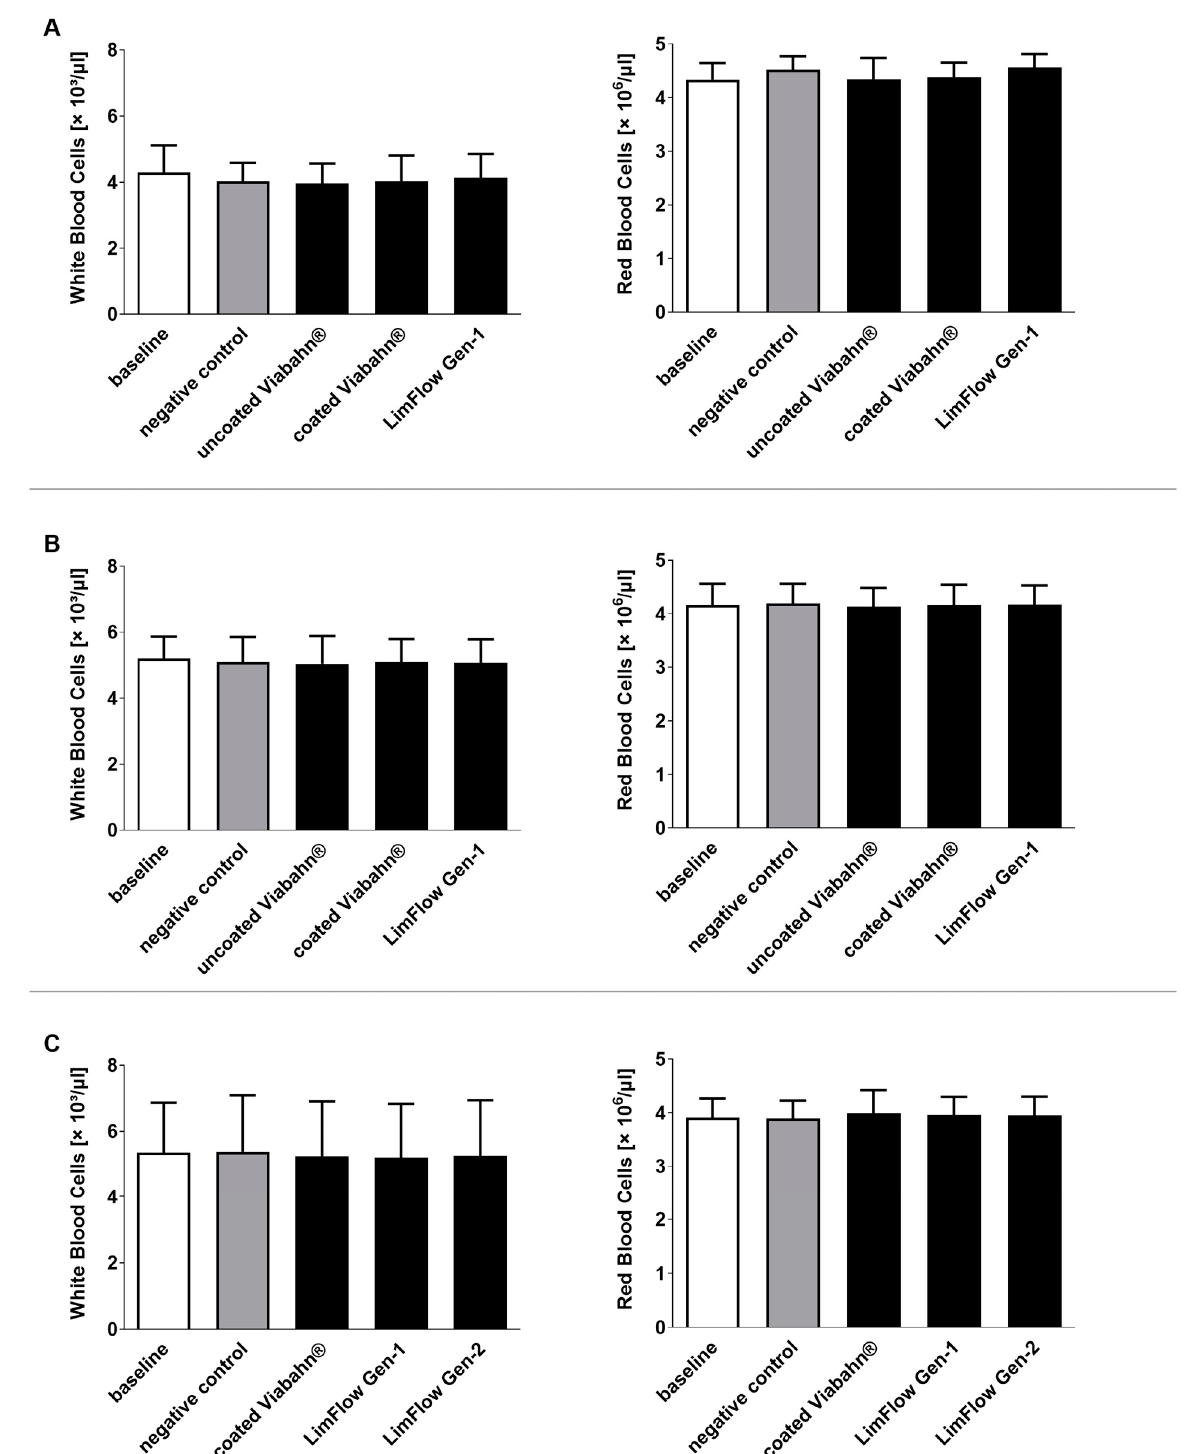
Figure 6. Analysis of white and red blood cell counts after the incubation of fresh human blood with test items for 60 min at 37 °C. ( A ) Pilot study ( n = 3), ( B ) Study B ( n = 8), ( C ) Study C ( n = 8). Whole human blood without incubation and contact to test material served as baseline and blood without test material, but with incubation as the negative control. The data are shown as mean + SD.